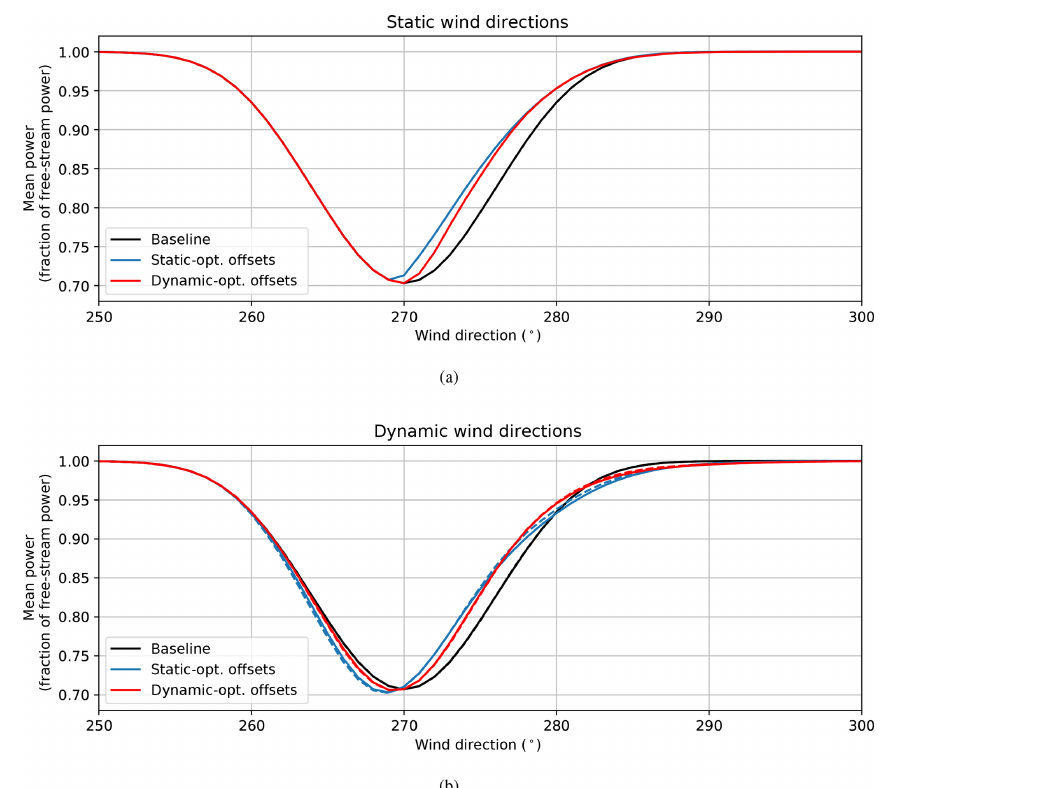
Figure 10. Normalized mean power of combined upstream and downstream turbines for baseline and wake steering control with static- optimal and dynamic-optimal yaw offset schedules for (a) static and (b) dynamic wind directions. Mean power values are determined from theory (solid) and simulation (dashed) for a turbine spacing of 5 D and turbulence intensity of 10% and plotted as a function of low-frequency wind